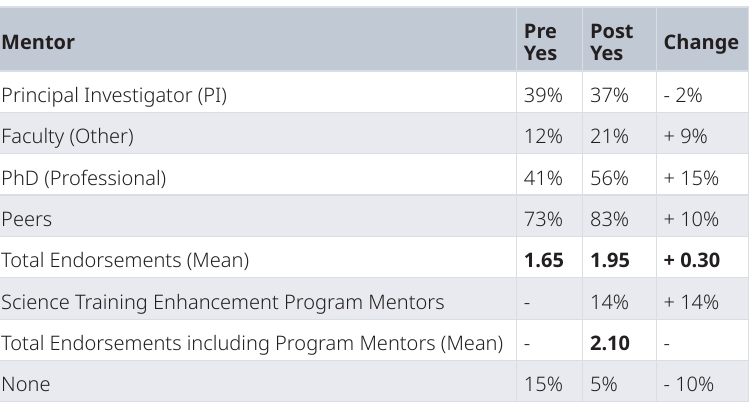
Table 5. Career professional mentorship (HINAP). Career and professional mentorship endorsements by category increased pre-to post-course participation, suggesting that more mentors were identified during course participation (increase or decrease noted).